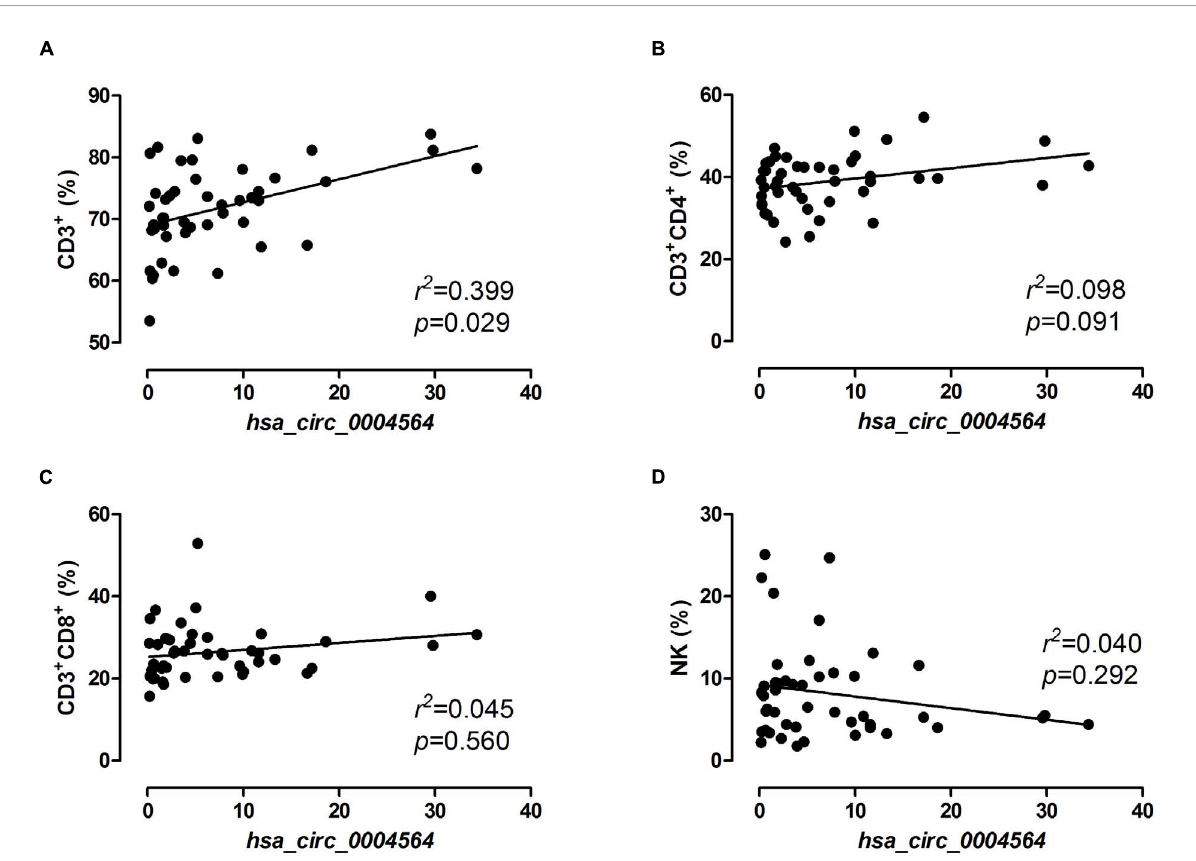
FIGURE5 Correlation analysis of hsa_circ_0004564 expression and immune cell subsets in children with T1D. Pearson’s correlation and linear regression after adjustments for CDAbs, age, sex, and duration of diabetes. (A) CD3 + cell. (B) CD4 + T cell. (C) CD8 + T cell. (D) NK cell. CDAbs, celiac disease autoantibodies; T1D, type 1 diabetes; NK, natural killer